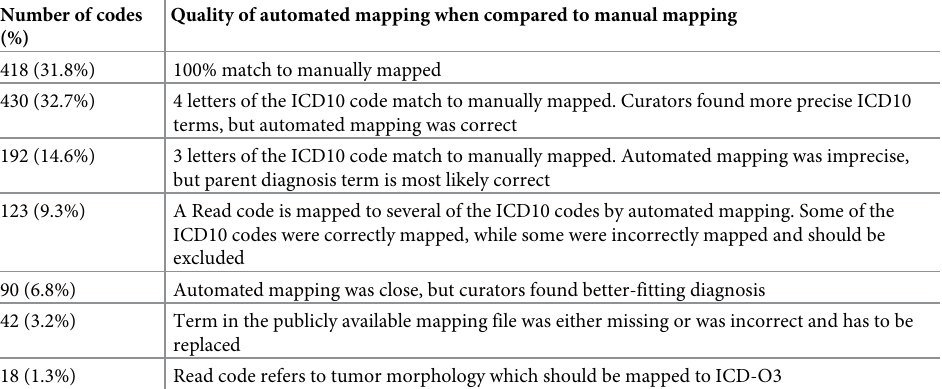
Table 3. Comparison of the overall quality of mapping between Read codes and ICD10-CM codes for a subset of 1,313 randomly selected Read codes from GP clinical